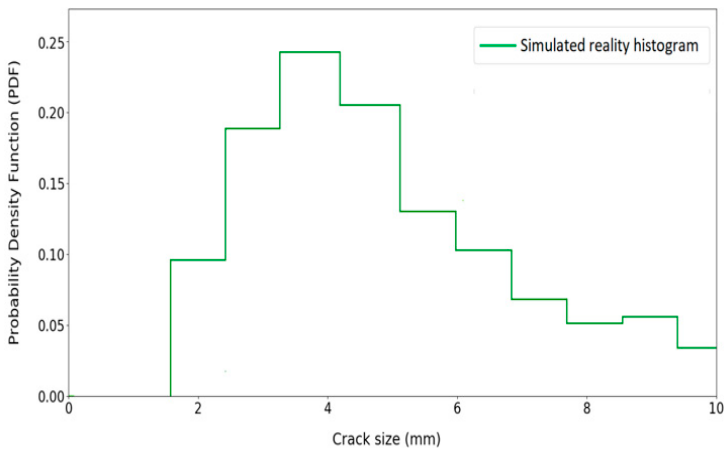
Figure 11. Simulated reality distribution for the crack size